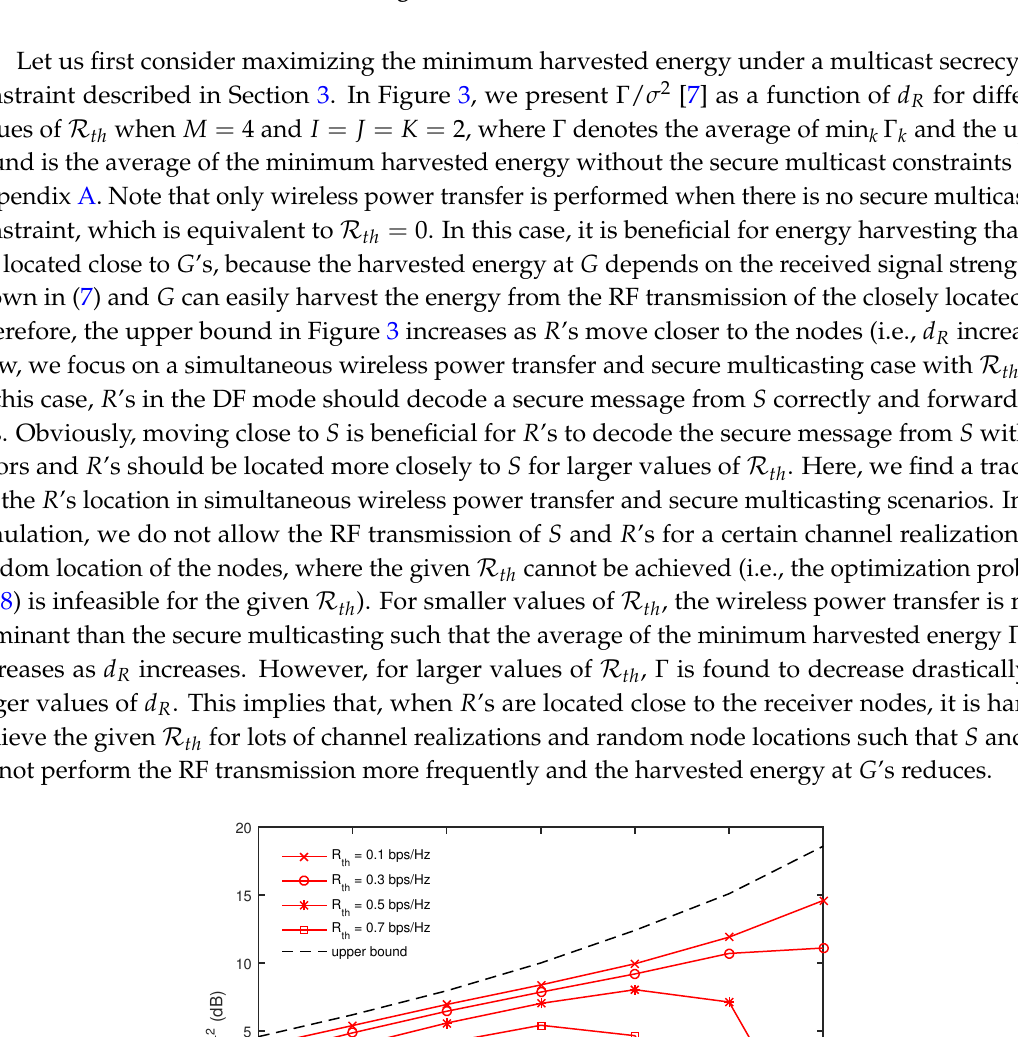
Figure 2. Simulation model.